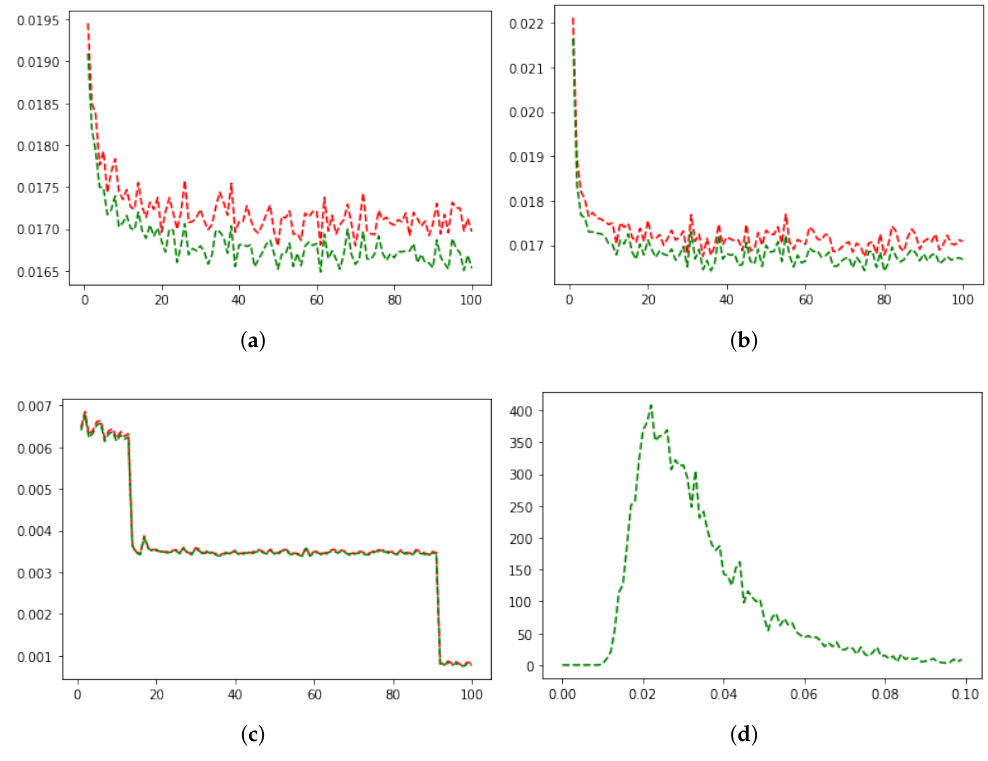
Figure 6. Cases with three scatterers, Mean square error ( a – c ) for each group of test data and distribution of mean square error of test data ( d